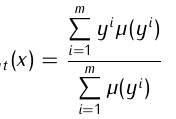
block diagram for the fuzzy controller is illustrated in Figure 6. Given the two position